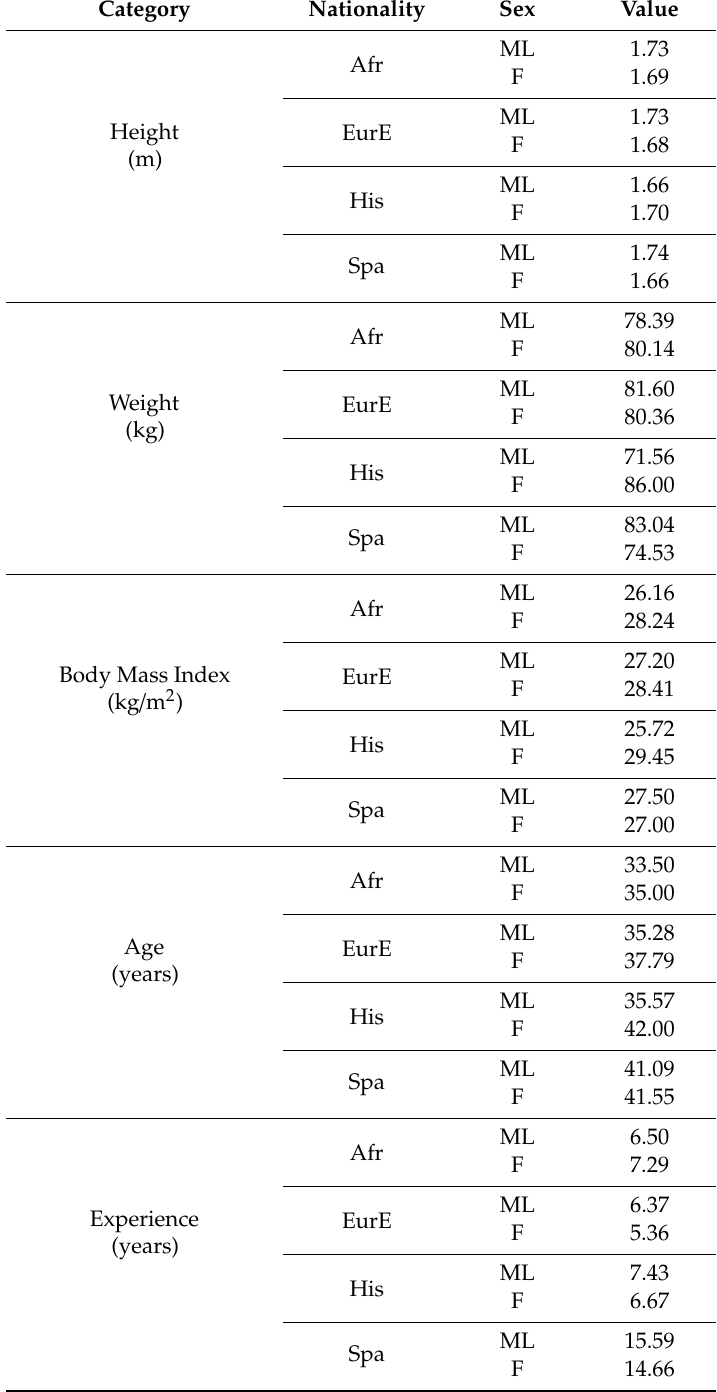
Abbreviations: Please see Table